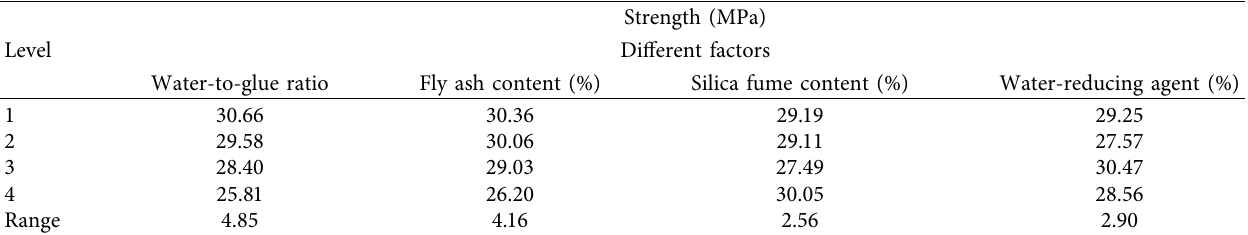
Table 4: Range analysis of 14-day compressive strength of concrete.